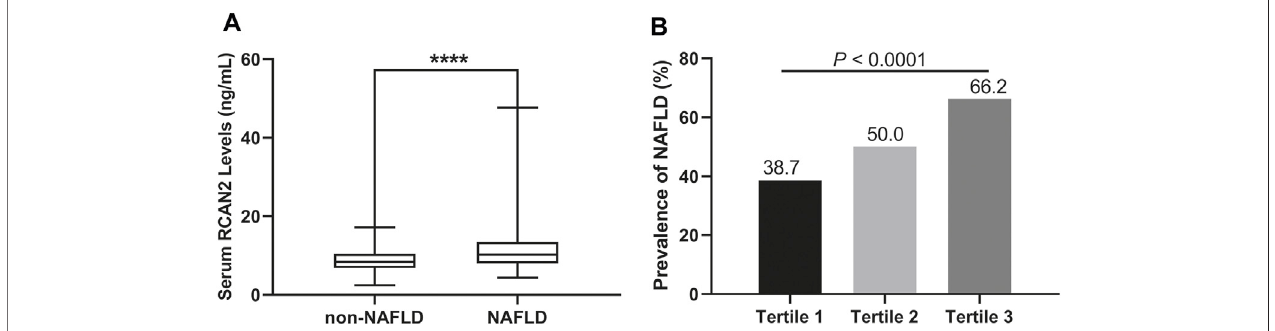
FIGURE 2 | (A) Serum RCAN2 concentration in NAFLD patients and non-NAFLD subjects. (B) Prevalence of NAFLD by tertiles of serum RCAN2 levels in all participants. NAFLD, non-alcoholic fatty liver disease; RCAN2, a regulator of calcineurin 2. **** p < 0.0001 compared with non-NAFLD.